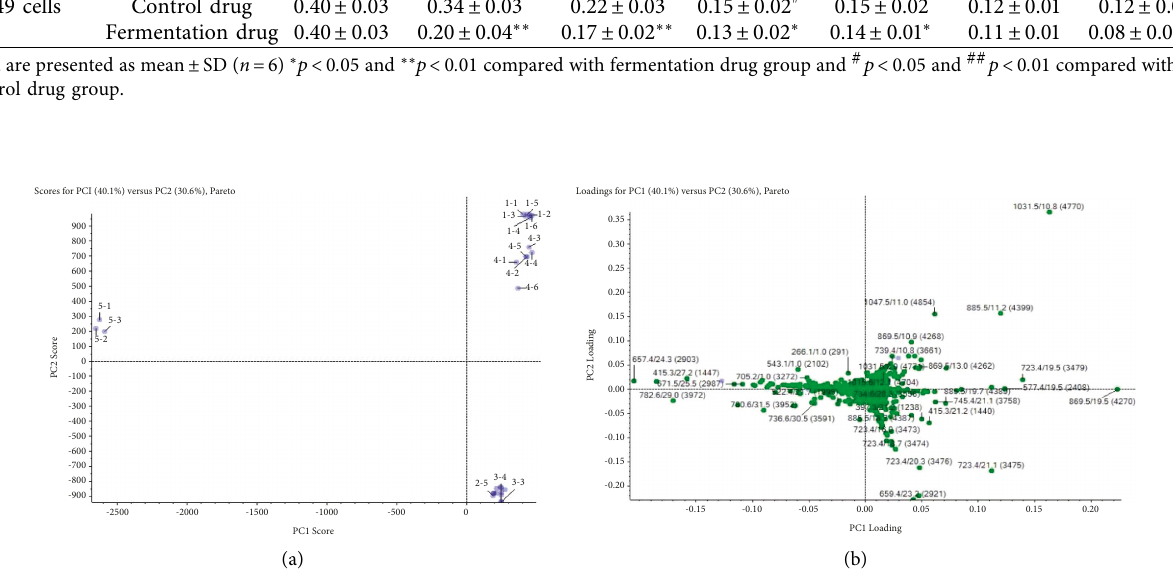
Figure 3: Score plot (a) and corresponding loadings plot (b) output from the principal component analysis. Note. 1: Dioscorea nipponica crude drug, 2: 15 d fermentation sample, 3: 20d fermentation sample, 4: control drug, and 5: C39 fungi blank. Because some data were concentrated in the same area of 2–5, 3–3, and 3–4, the score plot data are not shown; therefore, the area of 2–5, 3–3, and 3–4 represents